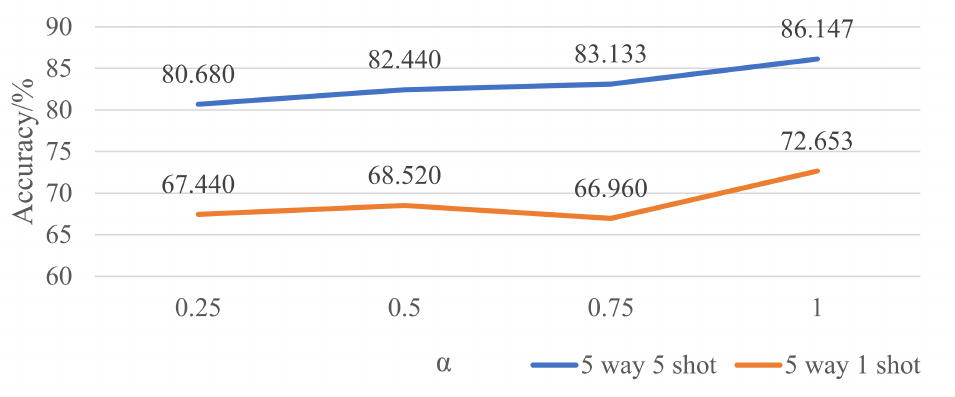
Figure 8. Experiments on extra loss from additional softmax layer against α in both five-way one-shot and five-way five-shot